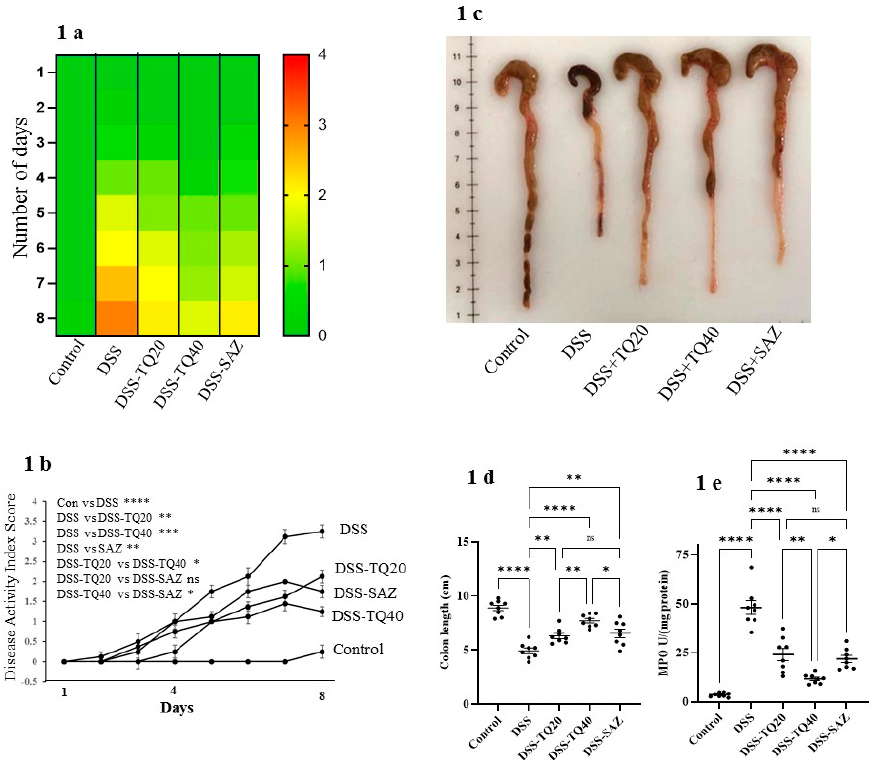
Figure 1. Effect of thymoquinone (TQ) on disease activity index (DAI), colonic length, and myeloperoxidase activity. ( a ) Shows the heat map of DAI; green color indicates no change in DAI scores, and red color indicates a severe increase in DAI scores. ( b ) DSS administration increased DAI scores significantly. TQ and sulfasalazine (SAZ) significantly limited the increase in DAI scores induced by DSS. ( c , d ) DSS markedly decreased the mean colon length. TQ and SAZ treatment partially prevented the decrease in colon length in the DSS group. ( e ) MPO activity was significantly higher in DSS groups. TQ and SAZ significantly decreased MPO activity in the DSS group. n = 8 animals used in each group to obtain the data. The data expressed as means ± SEM. **** p < 0.0001, *** p < 0.001, ** p < 0.01, and * p < 0.05. (NS) not significant.